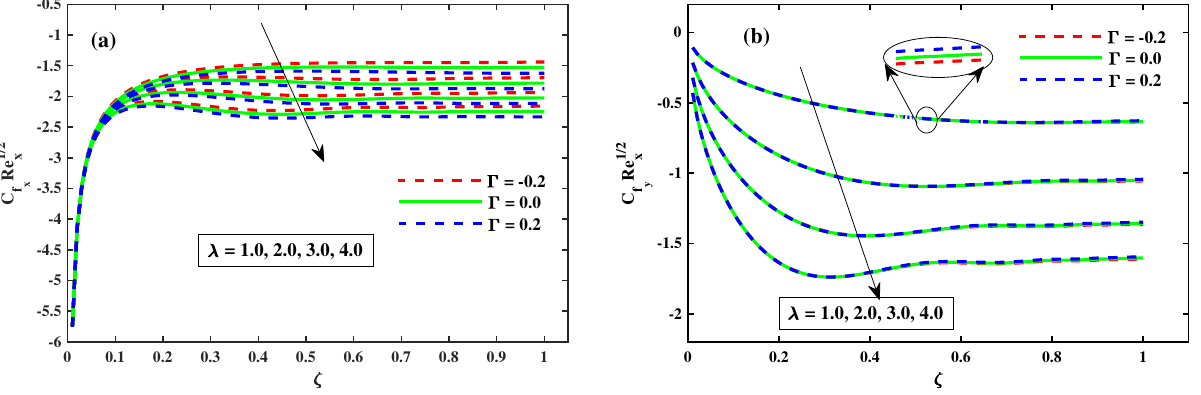
Figure 7. Impact of λ of Cf x Re 1/2 x along x-direction in ( a ), and Cf y Re 1/2 y along y-direction in ( b